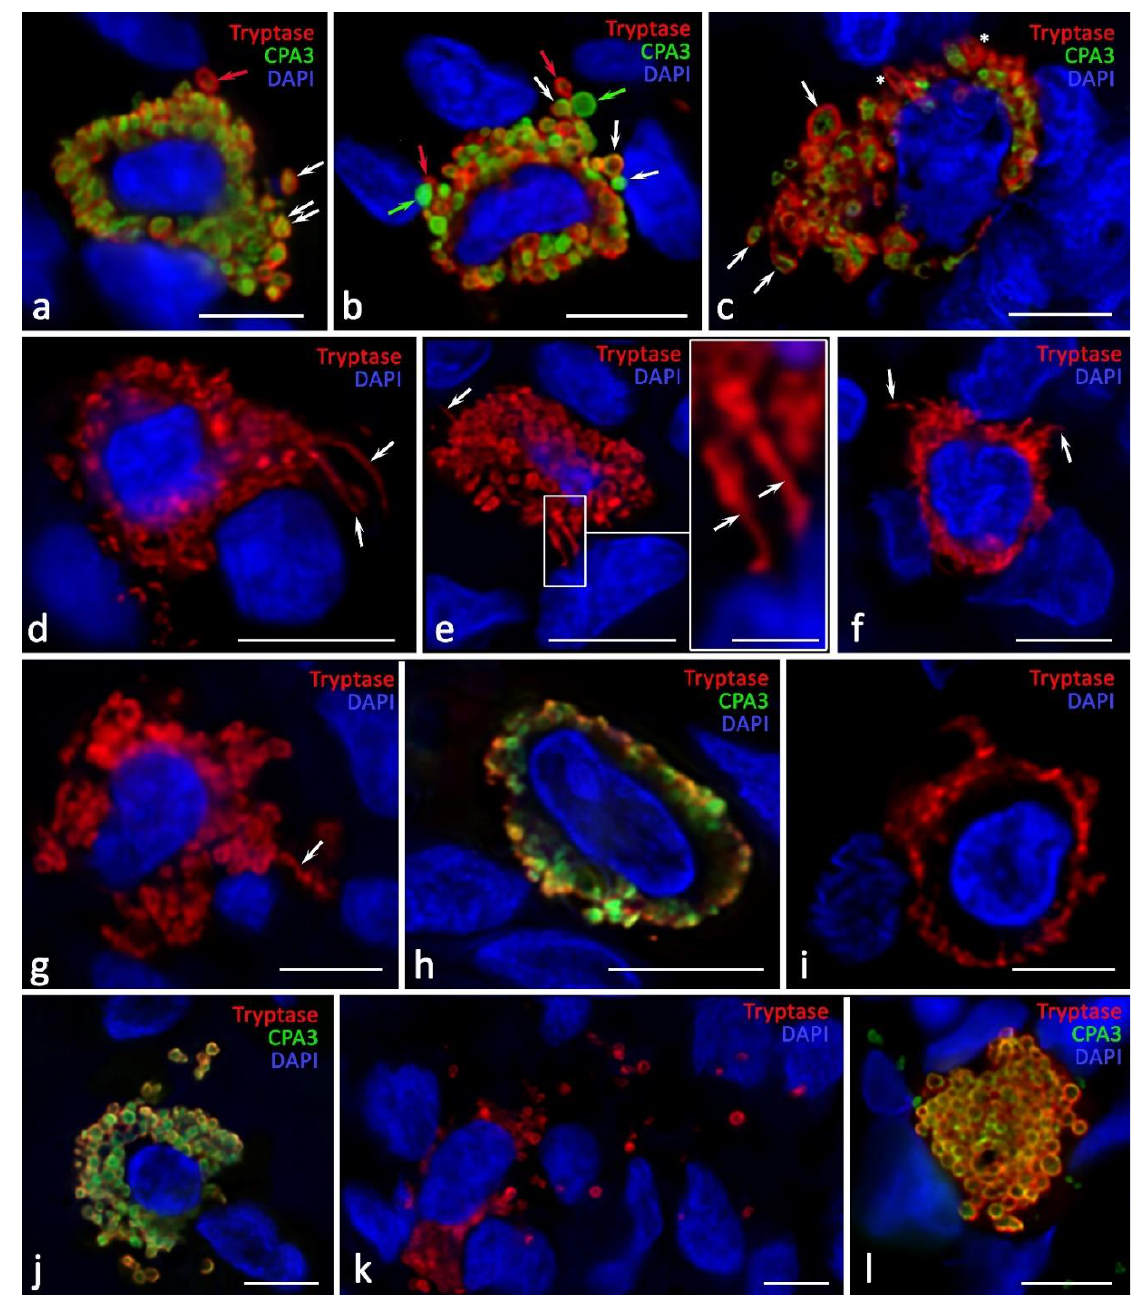
Figure 6. Secretory pathways of specific ovarian mast cell proteases in the development of endometri- omas. ( a – c ) Entry of MC secretory granules of various phenotypes and sizes into the extracellular matrix: Tr + CPA3 − (indicated by a red arrow), Tr − CPA3 + (indicated by a green arrow), and Tr + CPA3 + (indicated by a white arrow). There is the potential of selective CPA3 secretion in the extracellular matrix from secretory granules with the Tr + CPA3 + phenotype (( a ), indicated by a double arrow). Secretory granules can change their shape to be elongated in the direction of cellular targets (( c ), indi- cated by an asterisk). ( d – g ) Formation of cytoplasmic outgrowths of various lengths and thicknesses (tunneling nanotubes), filled with proteases, to the targets of a specific tissue microenvironment (indi- cated by an arrow). ( h , i ) Morphological signs of secretion through the mechanism of transgranulation. ( j , k ) Entry of granules of various phenotypes into the extracellular matrix and their spread over large areas of the tissue. ( l ) Formation of large-sized nuclear-free fragments of the cytoplasm located in the local tissue microenvironment. Scale: 5 µ m for the entire layout and 1 µ m for the insert in ( e